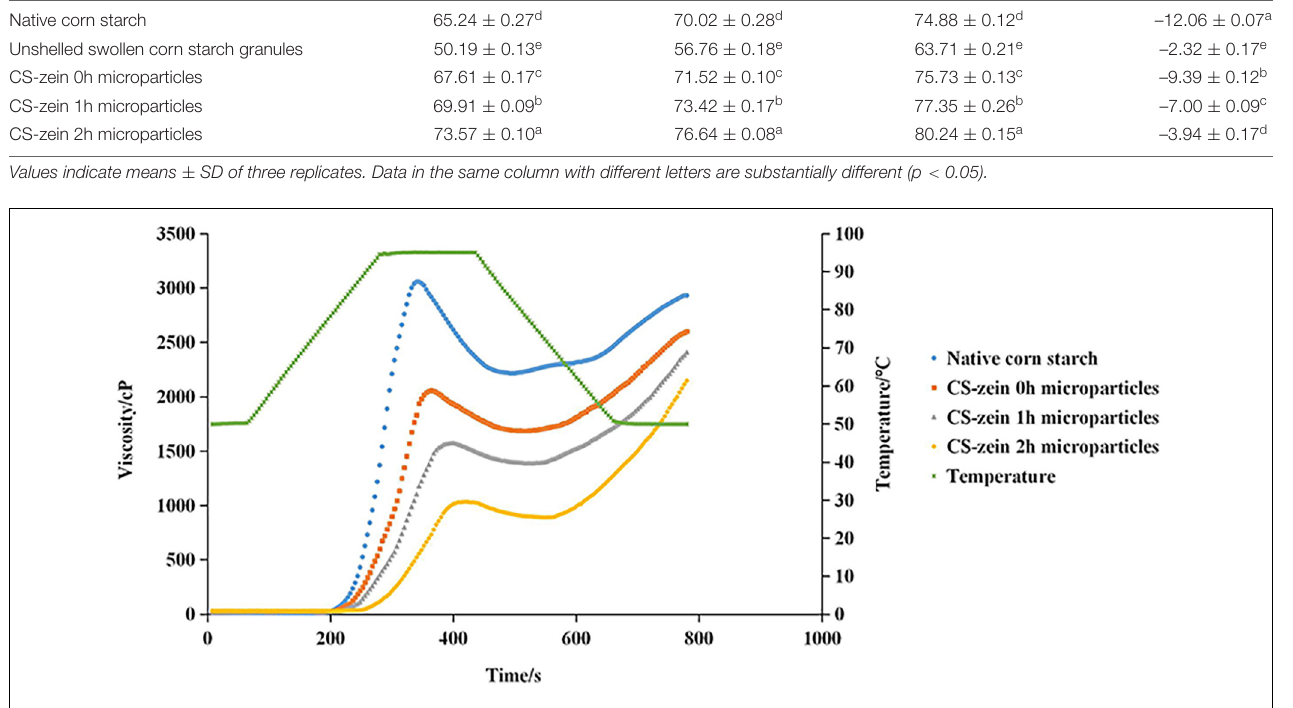
Frontiers in Nutrition |